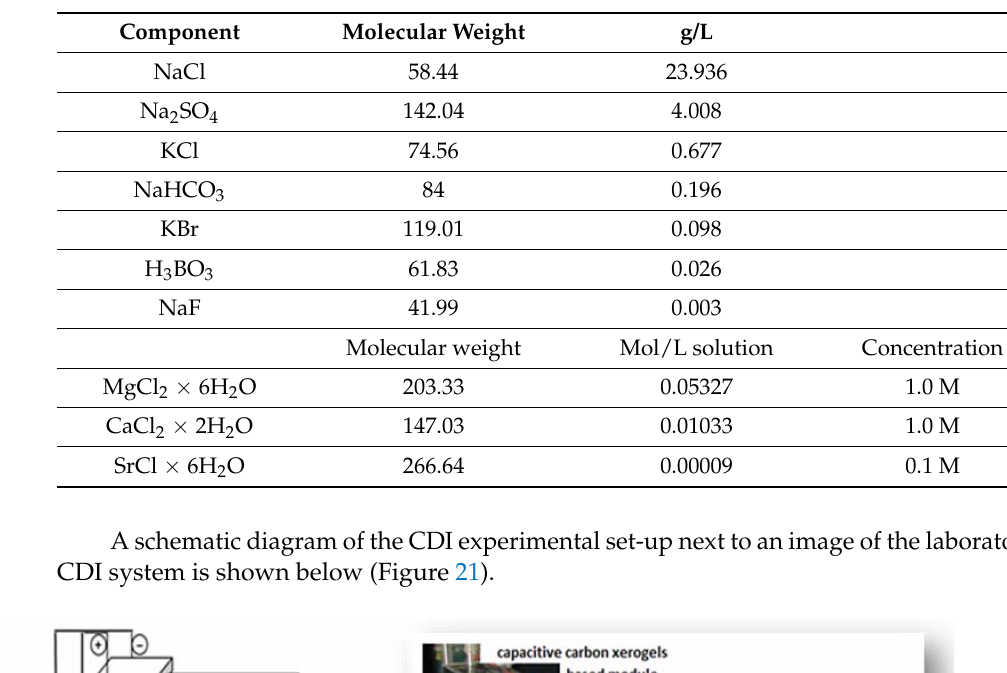
Table 4. Artificial sea water composition.